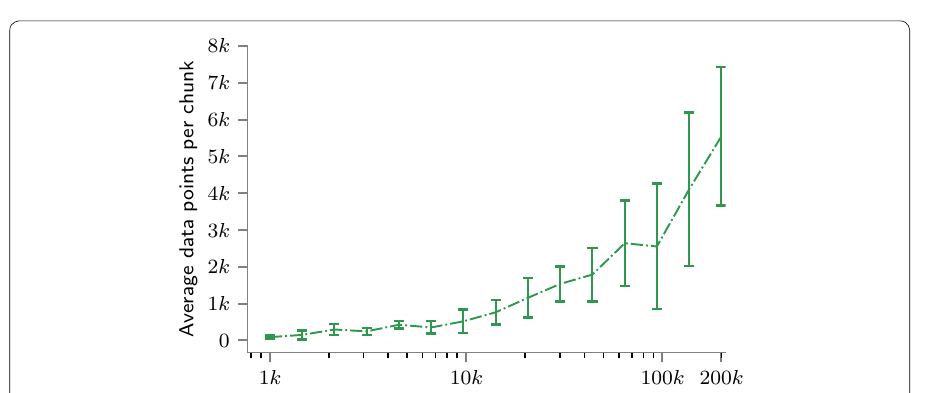
Fig. 25 Mean size of partitions with SD